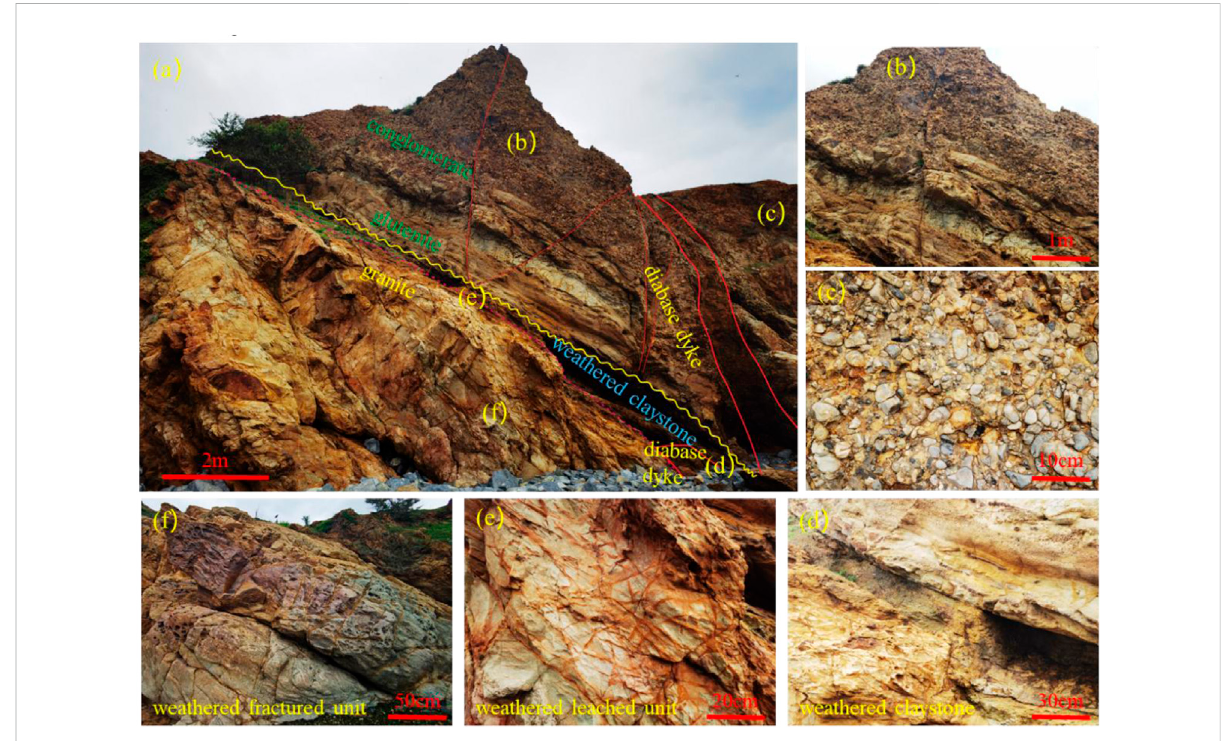
FIGURE 9 Paleo-weathering crust structure and fracture distribution at Longhuitou scenic spot. (A) Overall characteristics of weathering crust and fractures; (B) fracturecharacteristicsinglutenite; (C) fracturecharacteristicsinconglomerate; (D) fracturecharacteristicsinweatheredclaystone; (E) fracture characteristics in semi-weathered leached unit; (F) fracture characteristics in semi-weathered fractured